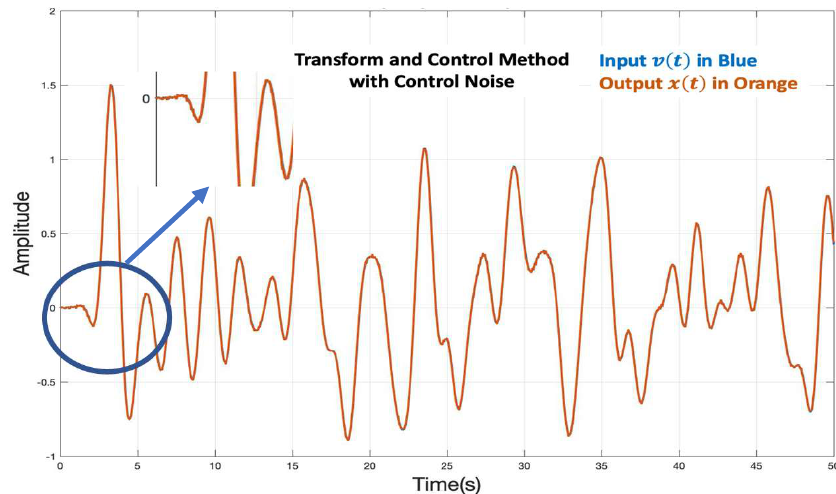
Figure 25. Impact of Noise on Control Performance (New Method).